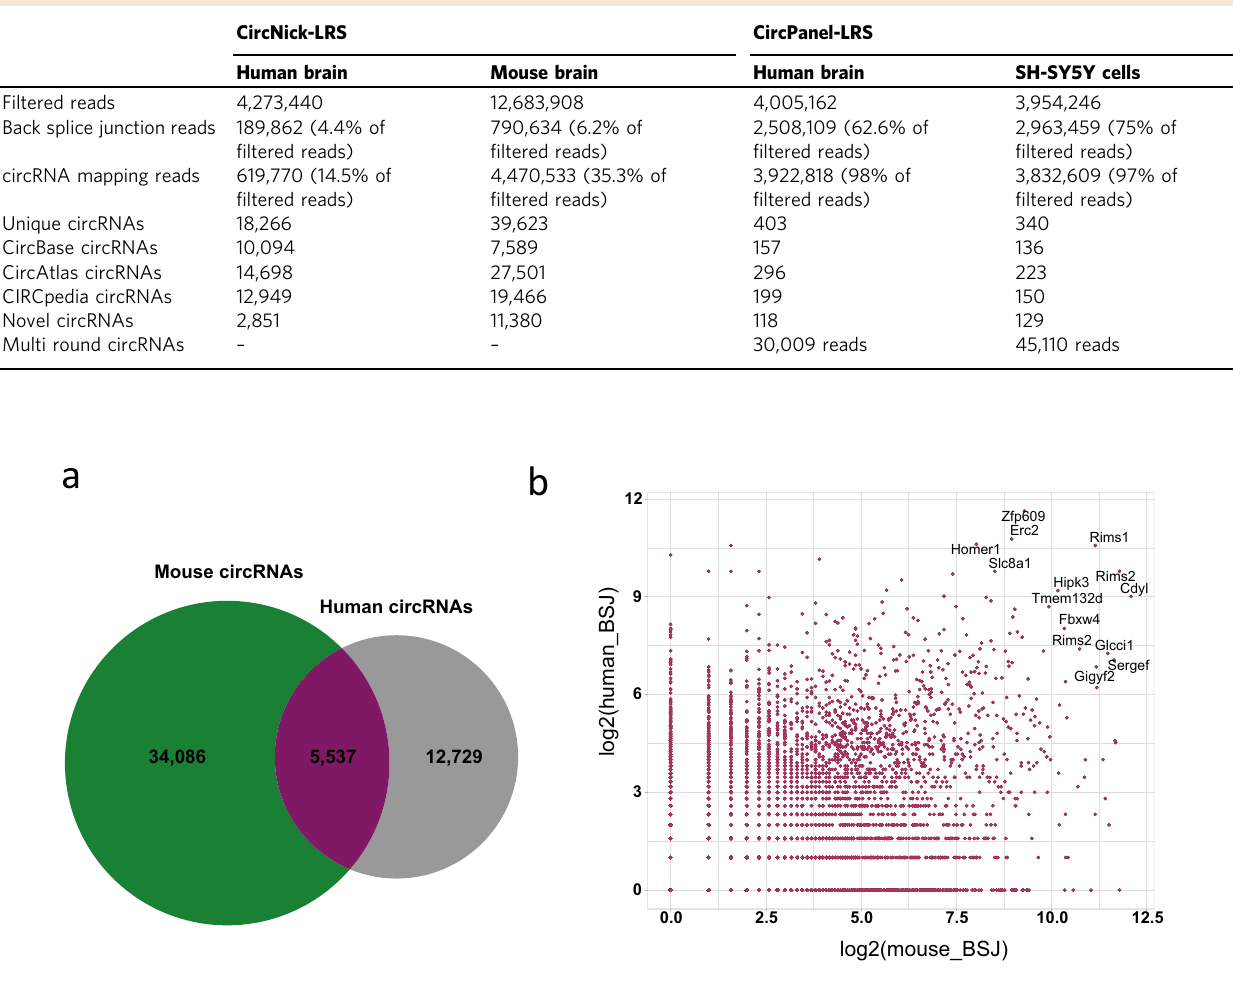
Table 1 Information on reads that map to circRNAs and the BSJ reads in each dataset.